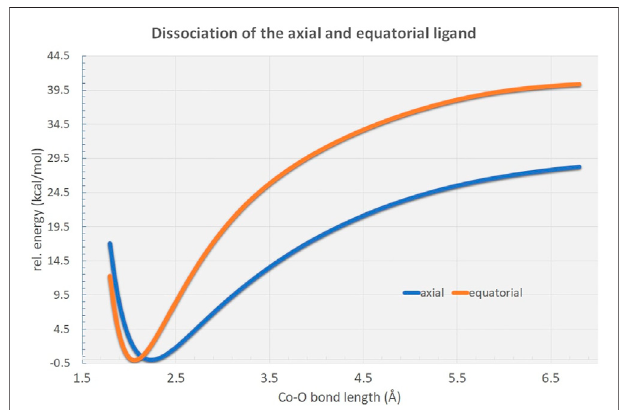
FIGURE 4 | Rigid potential energy surface scans along the R Co − O distance in the [Co(OH 2 ) 6 ] 2+ hexaaqua complex at the B3LYP/6-31G* level of theory. As can be fi gured from the curves, the axial ligand dissociation is energetically highly favored in comparison to the equatorial ligands by approximately 12 kcal/mol.